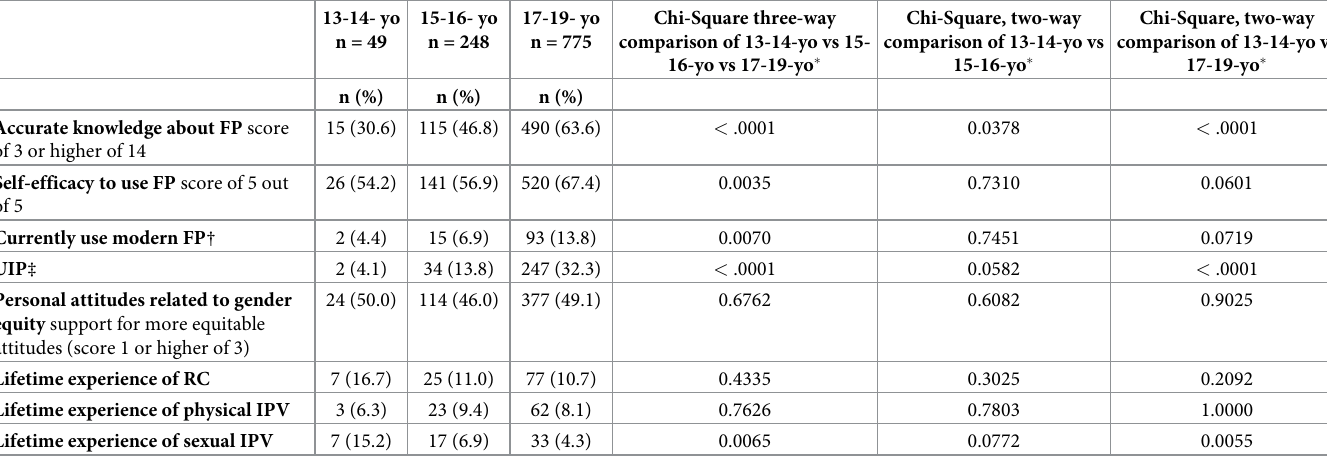
Table 2. Frequency of reproductive health, gender equity, and partner violence factors experienced among married AGYWs in Dosso region, Niger, by age group.